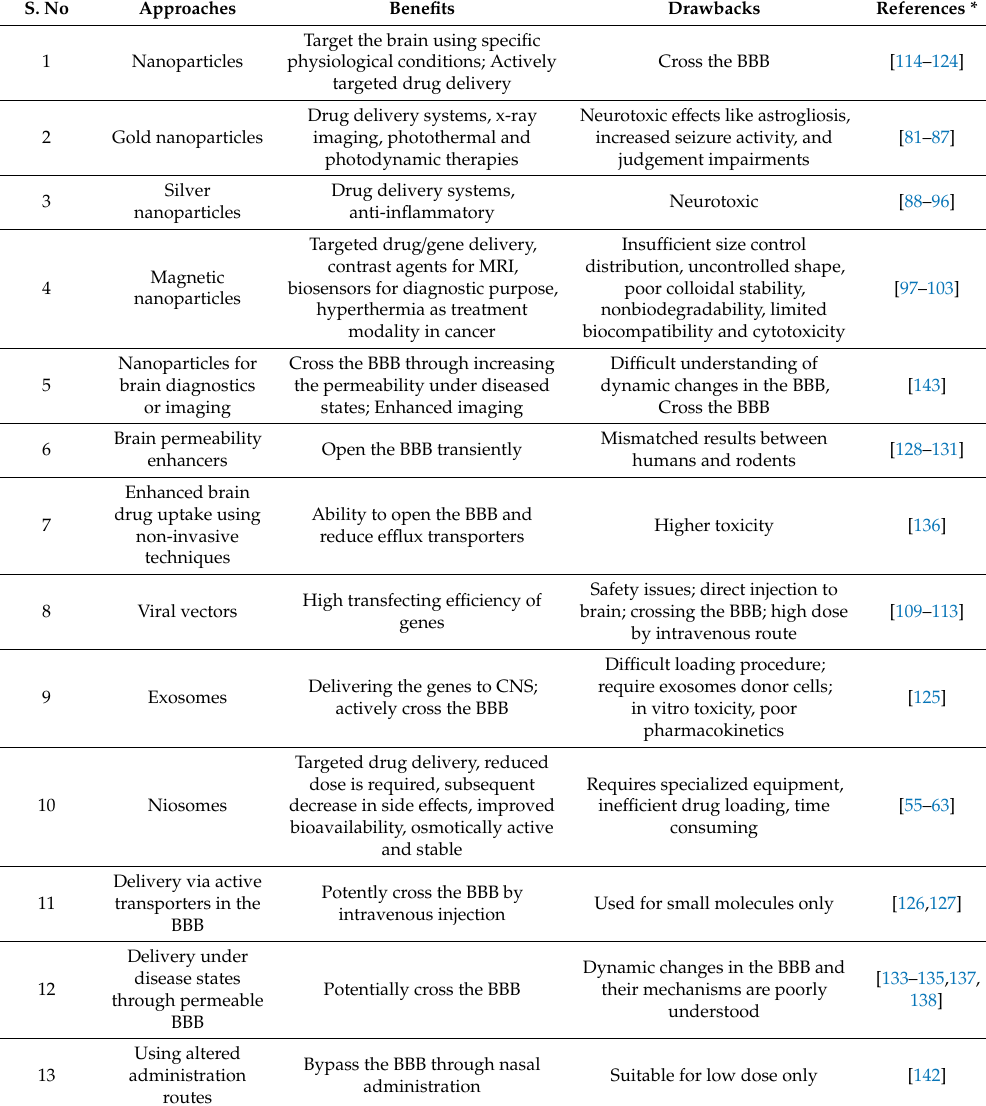
Table 1. Approaches for brain drug